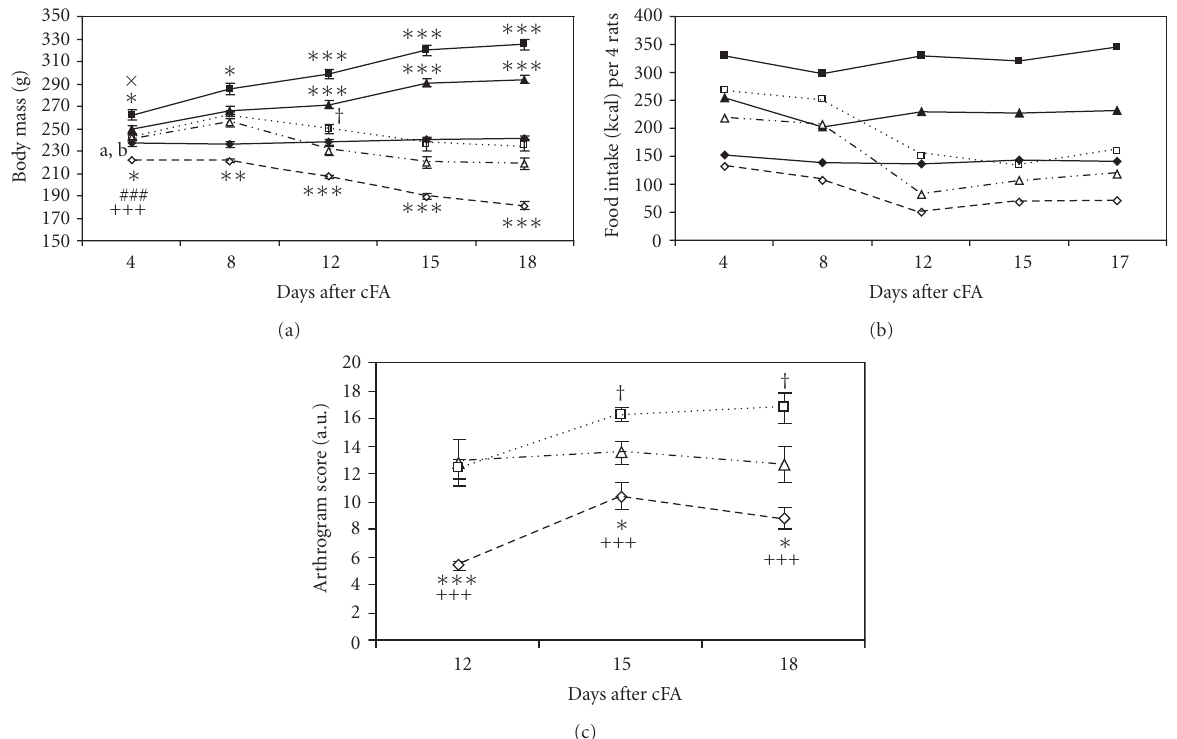
Figure 1: Body mass (a) and food intake (b) in control rats on standard diet (CN = (cid:2) ), high-fat diet (SHF = (cid:3) ), and food restriction (FR = (cid:4) ), and in arthritic rats on standard diet (AA-N = (cid:5) ), high-fat diet (AA-SHF = (cid:6) ), and food restriction (AA-FR = ♦ ) in selected days after cFA inoculation. Values for food intake are presented as means of 2 cages (4 rats per cage). Statistical significance between the body mass values in arthritic rats and their corresponding controls on the same dietary regime: ∗ P < . 05, ∗∗ P < . 01, ∗∗∗ P < . 001. Significant di ff erence between AA-N and AA-SHF: † P < . 05. First day of significant di ff erences: CN versus SHF × P < . 05, FR versus CN a P < . 05, FR versus SHF b P < . 001, AA-FR versus AA-N ### P < . 001, and AA-FR versus AA-SHF +++ P < . 001. E ff ects of dietary interventions on the severity of arthritis expressed by arthrogram score (c). Significant di ff erence between AA-FR and AA-N: ∗ P < . 05, ∗∗∗ P < . 001; significant di ff erence between AA-FR and AA-SHF: +++ P < . 001; significant di ff erence between AA-SHF and AA-N: † P < . 05.